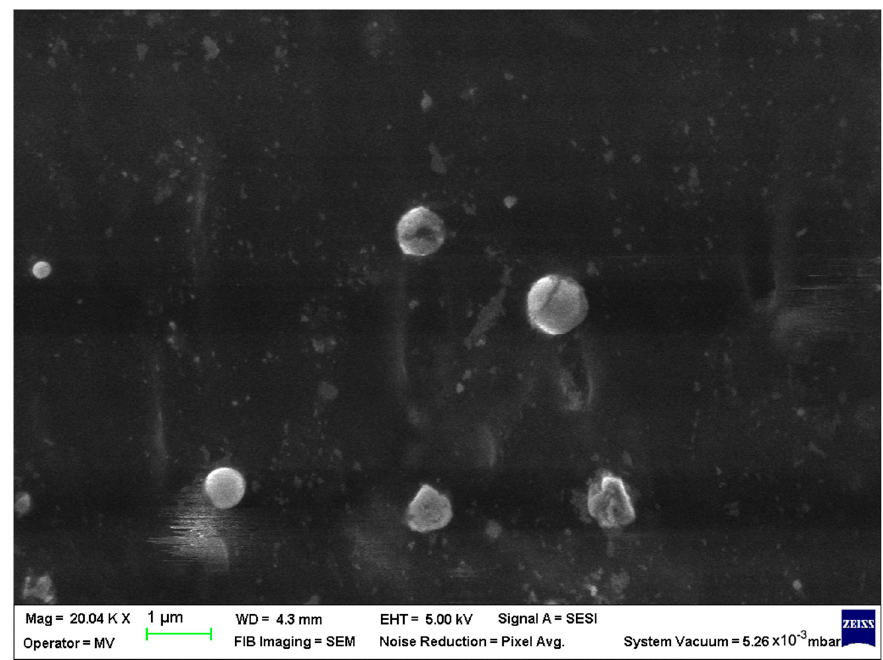
Figure 14. SEM micrographs of PET–HDPE–Fe composite (M14) sample at T 0 (1 μ m scale).